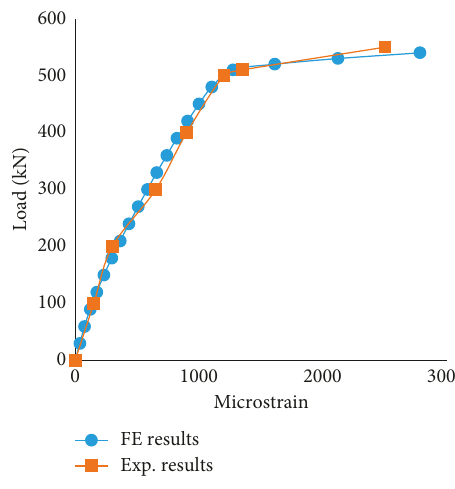
Figure 7: Strain curve (strain gauge 1) of steel